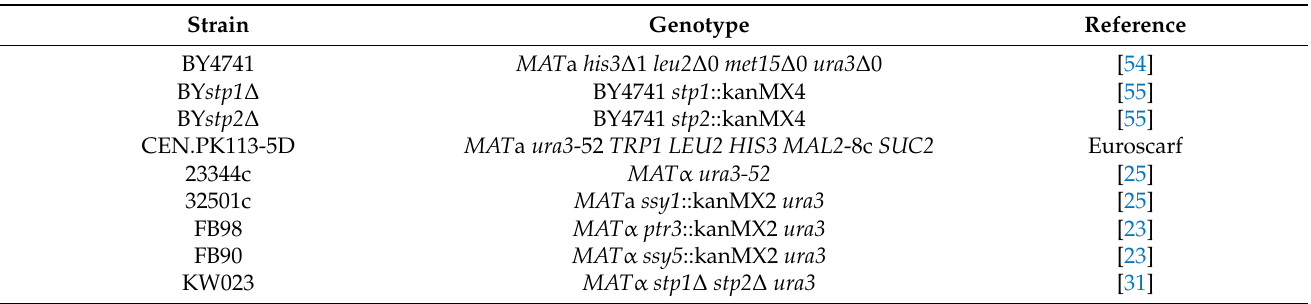
Table 1. Yeast strains employed in this